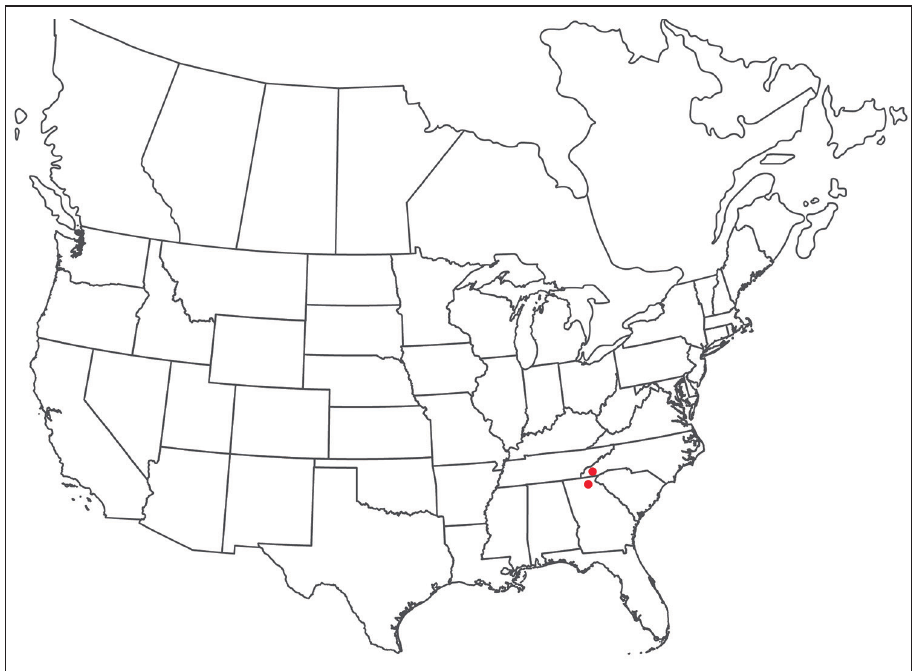
Figure 143. Torrenticola microbiscutella sp. n.